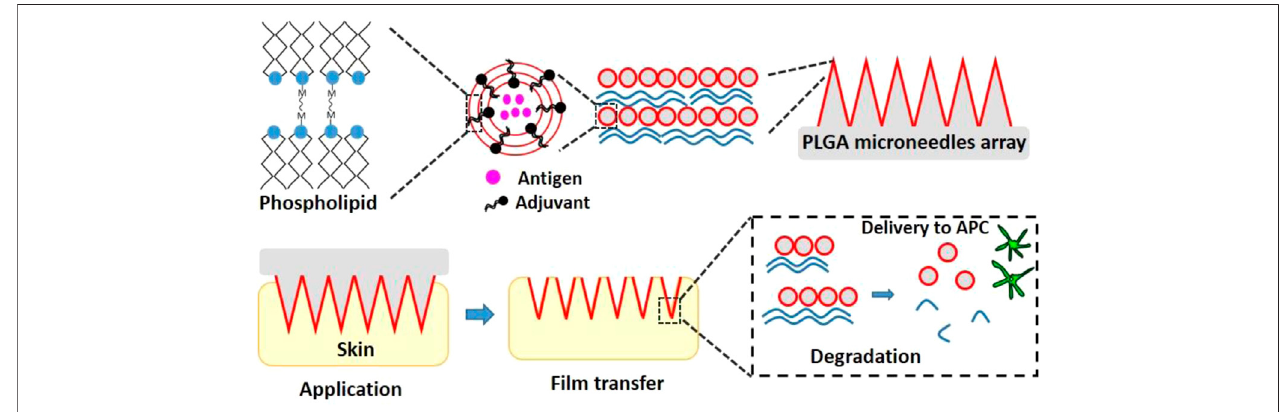
Frontiers in Bioengineering and Biotechnology |